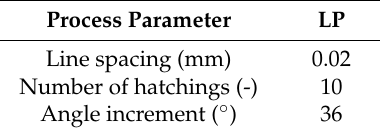
Table 8. Hatching parameter values for LP.